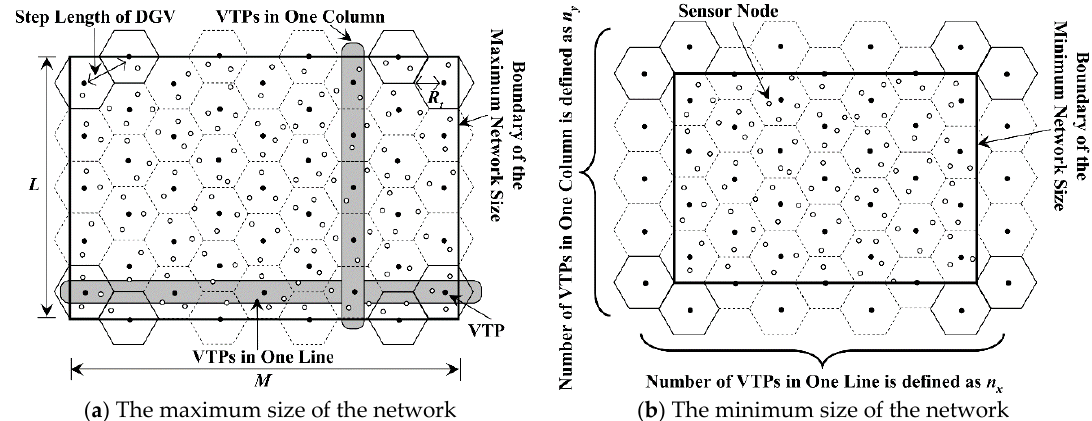
Figure 7. Distribution of the virtual traverse points.